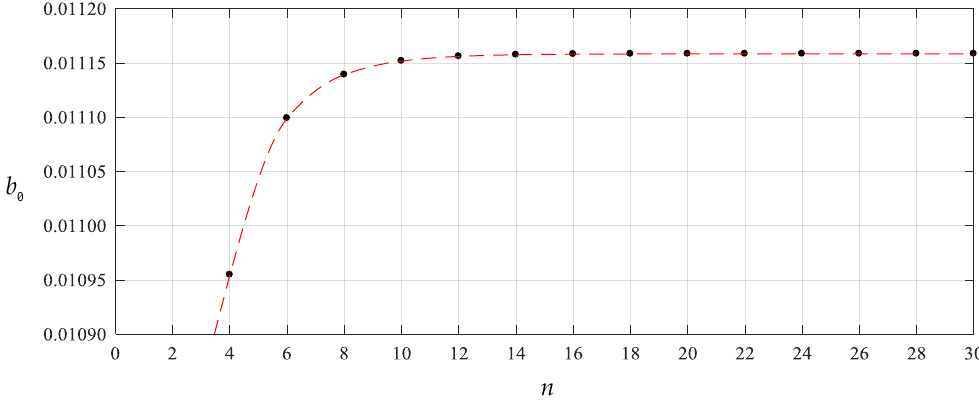
Figure 4 . Variation of Figure 4. Variation of b 0 with n